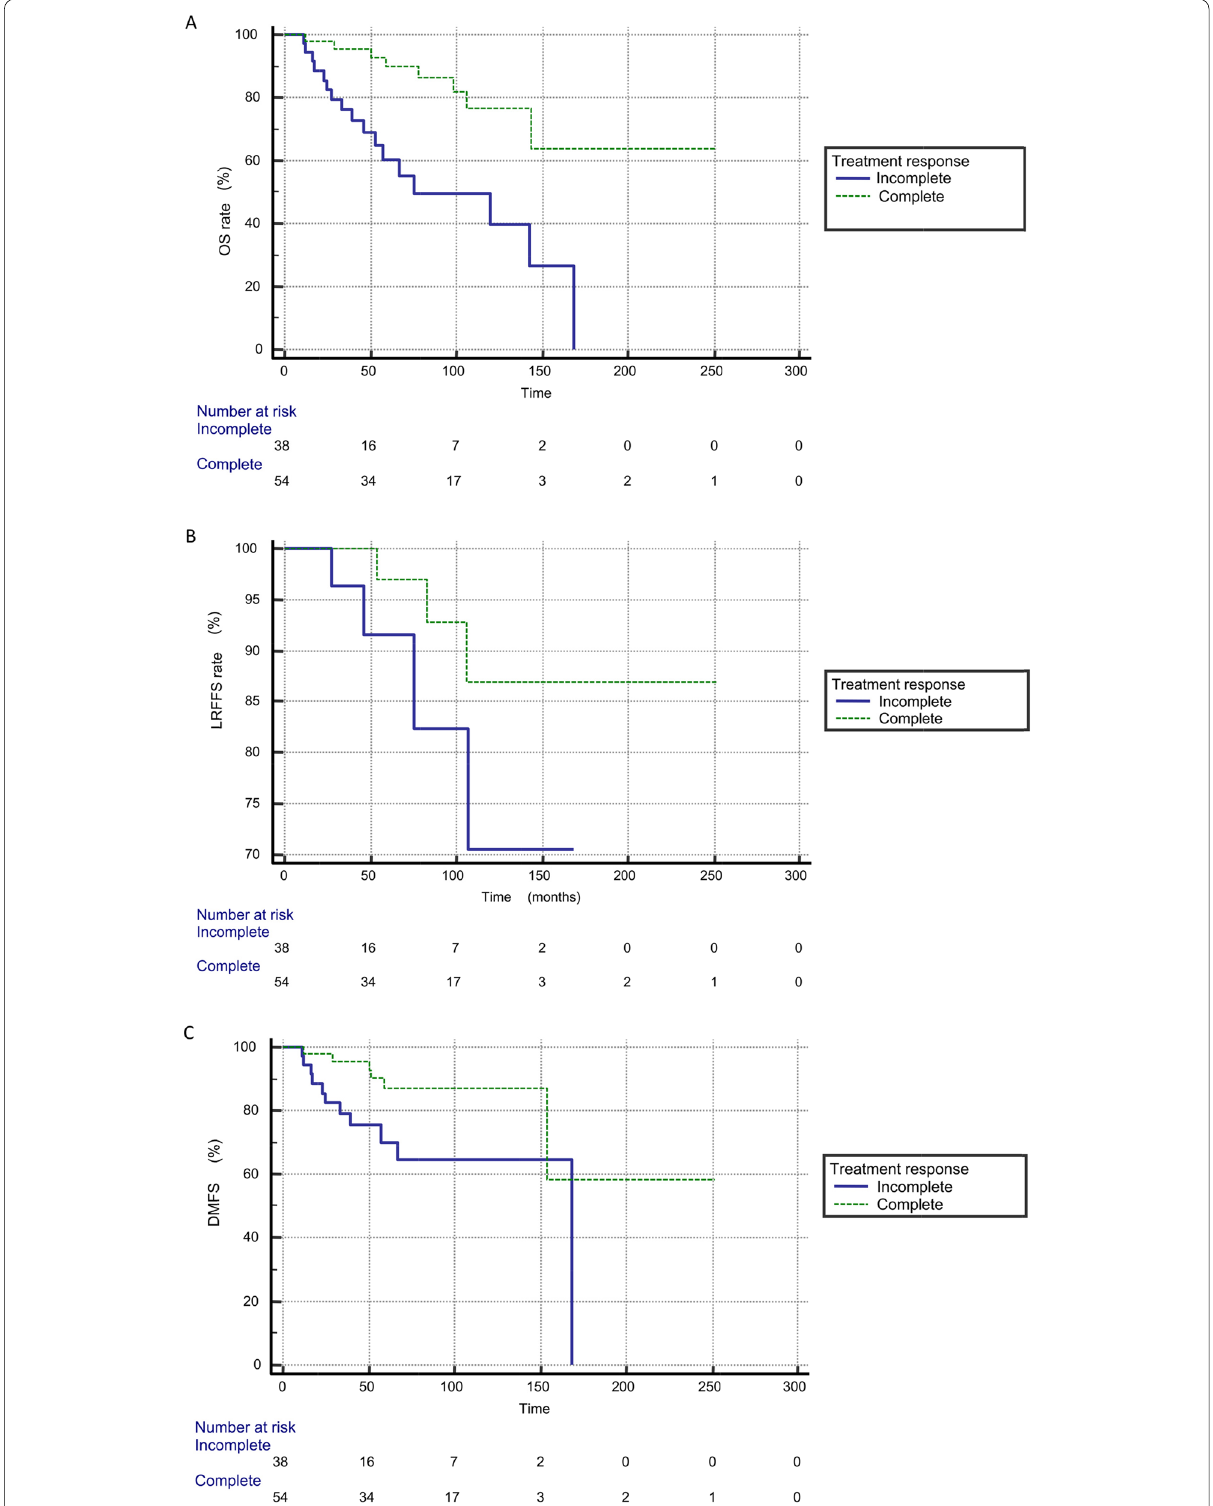
Fig. 1 Kaplan–Meier curve for patients with nasopharyngeal carcinoma with an incomplete response and complete response after treatment. ( A ) Overall survival (OS). ( B ) Distance metastasis free survival (DMFS). ( C ) Locoregional failure free survival